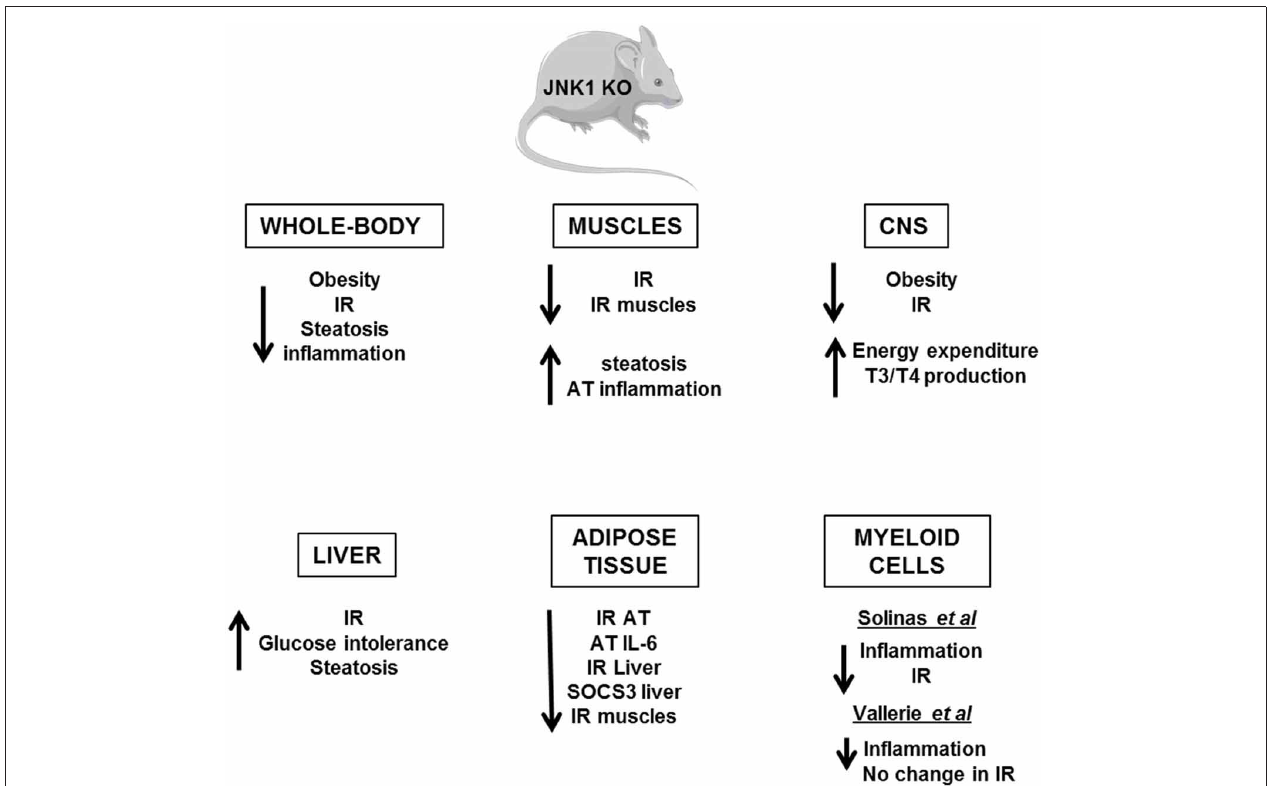
FIGURE 5 | Metabolic phenotype of whole-body JNK1 knockout mice and of conditional JNK1 knockout mice. Whole-body invalidation of JNK1 protects mice against diet-induced obesity and insulin resistance. Tissue-specific invalidation of JNK1 reveals that the lack of JNK1 in adipose tissue, muscles, or CNS protects against the development of